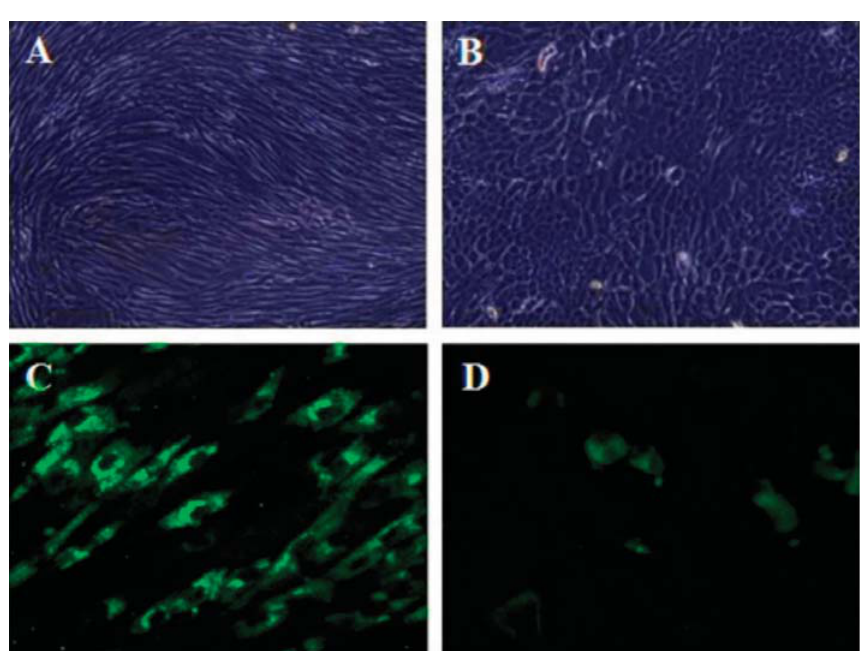
Figure 2- (cid:3)(cid:36)(cid:17)(cid:3)(cid:41)(cid:76)(cid:69)(cid:85)(cid:82)(cid:69)(cid:79)(cid:68)(cid:86)(cid:87)(cid:3)(cid:70)(cid:88)(cid:79)(cid:87)(cid:88)(cid:85)(cid:72)(cid:3)(cid:68)(cid:87)(cid:3)(cid:70)(cid:82)(cid:81)(cid:192)(cid:88)(cid:72)(cid:81)(cid:70)(cid:72)(cid:17)(cid:3)(cid:37)(cid:17)(cid:3)(cid:46)(cid:72)(cid:85)(cid:68)(cid:87)(cid:76)(cid:81)(cid:82)(cid:70)(cid:92)(cid:87)(cid:72)(cid:3)(cid:70)(cid:88)(cid:79)(cid:87)(cid:88)(cid:85)(cid:72)(cid:3)(cid:68)(cid:87)(cid:3)(cid:70)(cid:82)(cid:81)(cid:192)(cid:88)(cid:72)(cid:81)(cid:70)(cid:72)(cid:17)(cid:3)(cid:38)(cid:17)(cid:3)(cid:51)(cid:82)(cid:86)(cid:76)(cid:87)(cid:76)(cid:89)(cid:72)(cid:3)(cid:76)(cid:80)(cid:80)(cid:88)(cid:81)(cid:82)(cid:192)(cid:88)(cid:82)(cid:85)(cid:72)(cid:86)(cid:70)(cid:72)(cid:81)(cid:70)(cid:72)(cid:3)(cid:73)(cid:82)(cid:85)(cid:3)(cid:191)(cid:69)(cid:85)(cid:82)(cid:69)(cid:79)(cid:68)(cid:86)(cid:87)(cid:86)(cid:3)(cid:11)(cid:68)(cid:81)(cid:87)(cid:76)(cid:16)